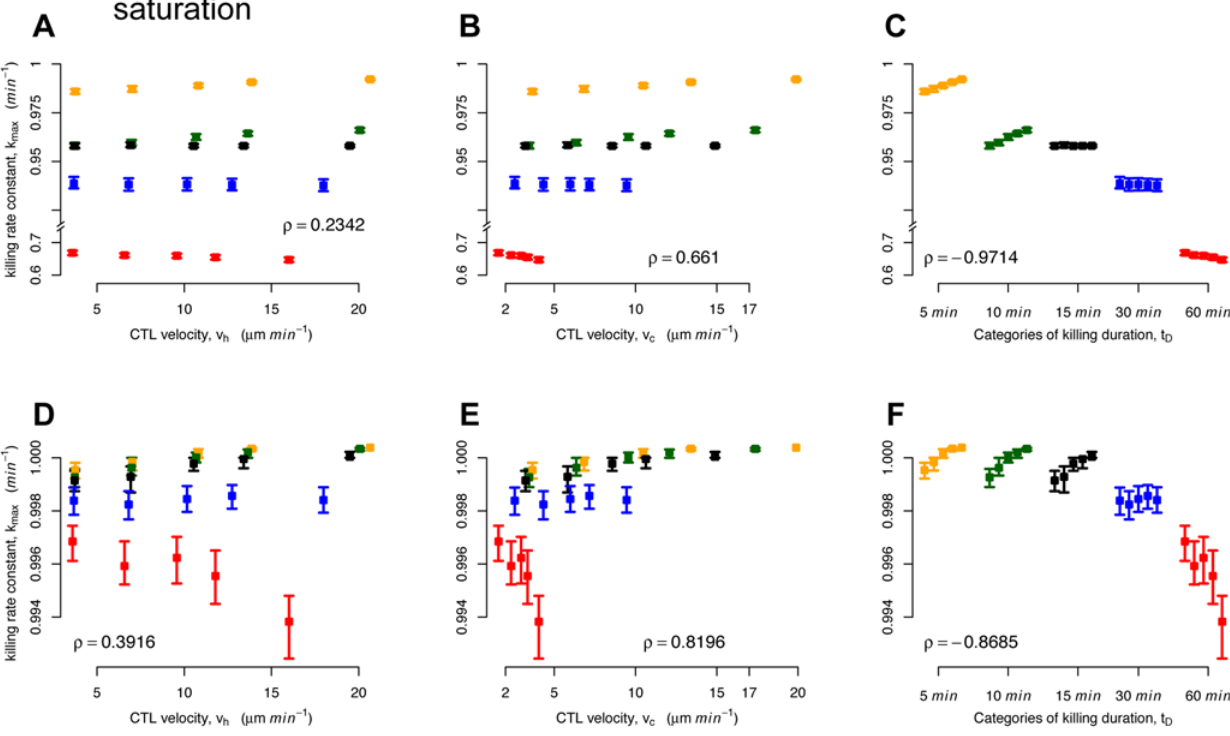
Figure 6. Plots of v h , v c and t D against the estimates of k max . The estimation was based on either counting free and bound target cells (shown in A–C) or only free target cells (shown in D–F). The mean, the minimum and the maximum over 1000 estimates are shown (neglecting outliers) as the 95% confidence intervals are, in most cases, too small to be plotted. Spearman’s rank correlation coefficient, r , is given. The color coding corresponds to the different levels of t D (5 min (orange), 10 min (green), 15 min (black), 30 min (blue), 60 min (red)). In each group of t D in C and F, the level of velocity is increasing from left to right. Please note that in A–C, the y-axis is split and scaling differs for graphical clarity.